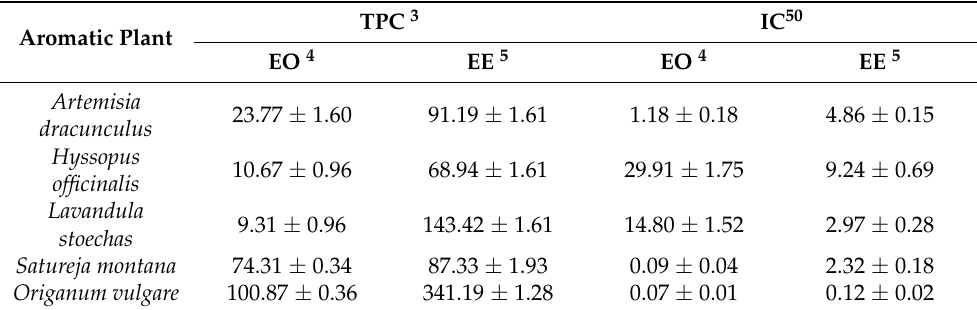
Table 6. Total phenolic content (mg GAE 1 /g extract) and antioxidant activity of aromatic